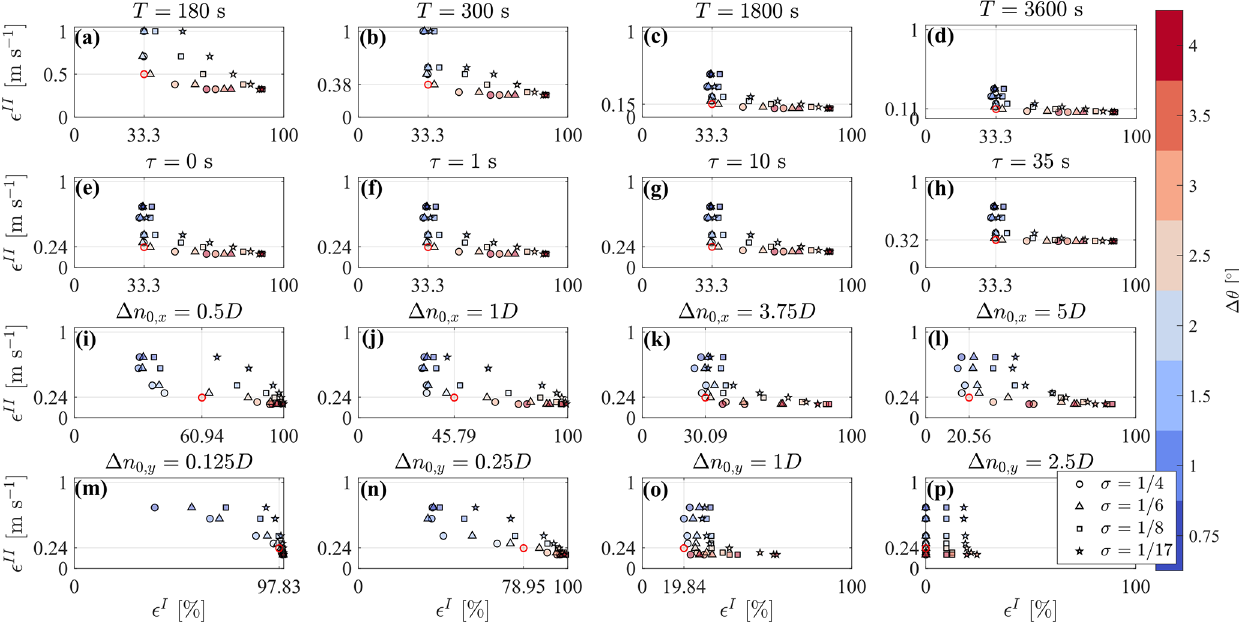
Figure 18. Pareto fronts for the design of the volumetric scan for different inputs. (a–d) Sensitivity to total sampling time T . (e–h) Sensitivity to integral timescale, τ . (i–l) Sensitivity to streawmise fundamental half wavelength, (cid:49)n 0 ,x . (m–p) Sensitivity to spanwise fundamental half wavelength, (cid:49)n 0 ,y . The parameters not indicated at the top of the figures are kept equal to the optimal design case identified in Sect.